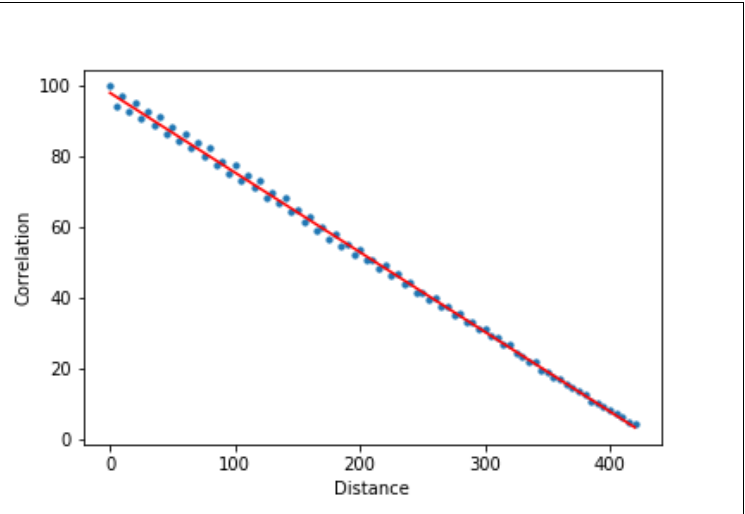
Figure 1. Correlation as a function of distance for location #1 (a neighborhood in Manhattan) for an altitude of 200 m (the blue points indicate the simulation results, and the red line represents the linear regression).